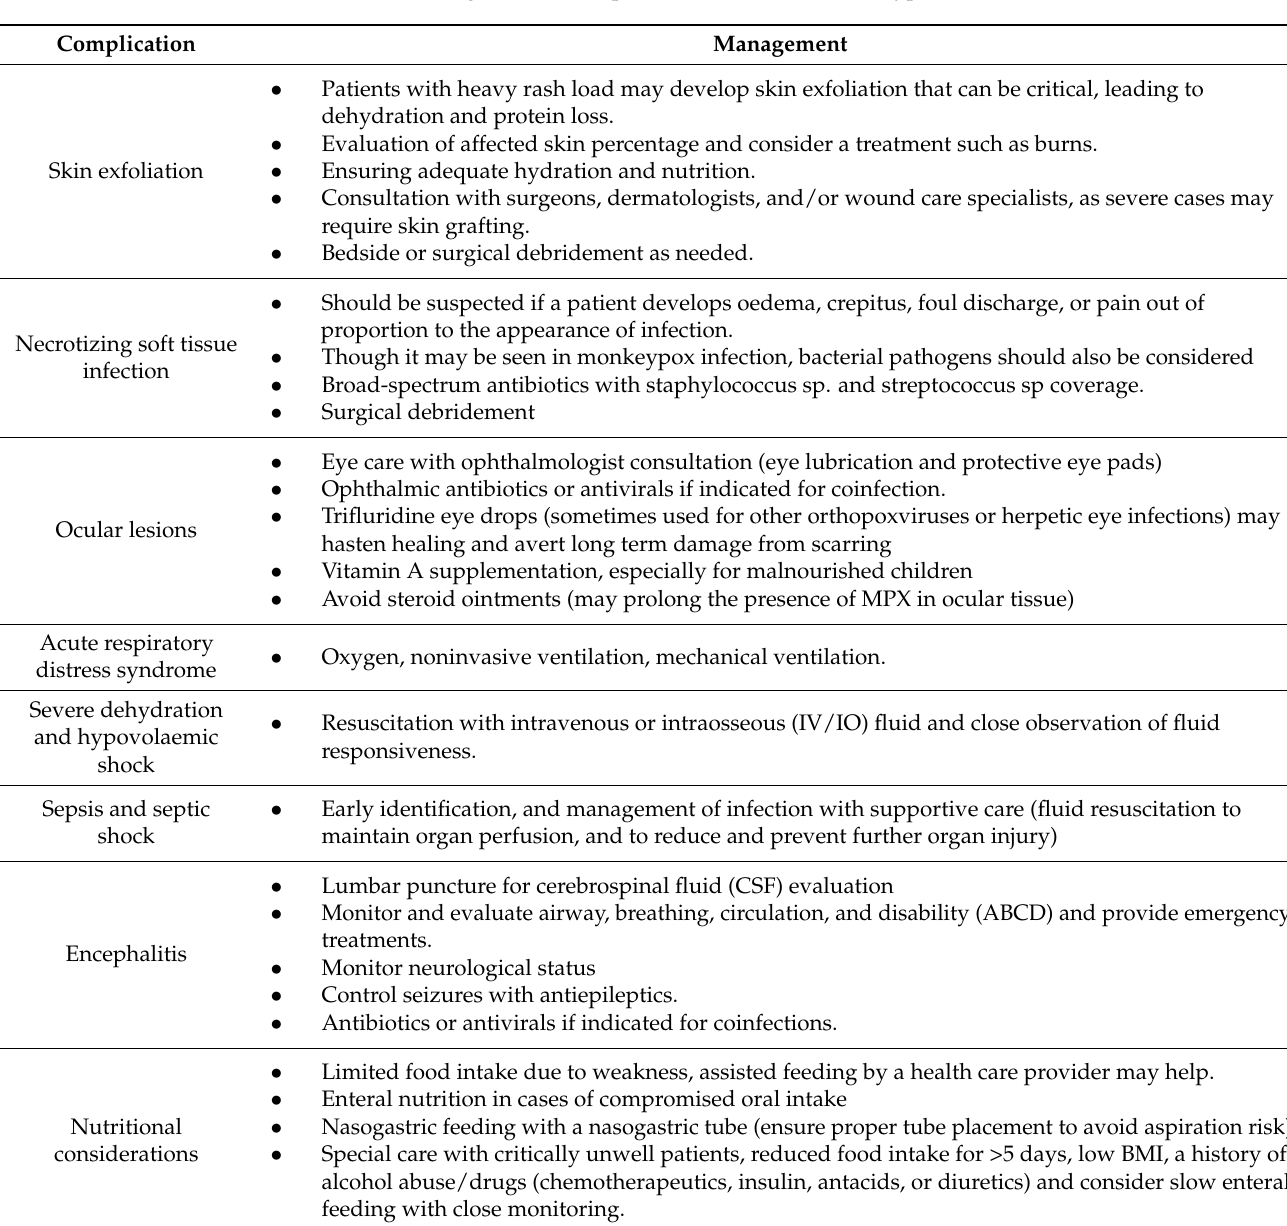
Table 4. Management of complications and severe monkeypox